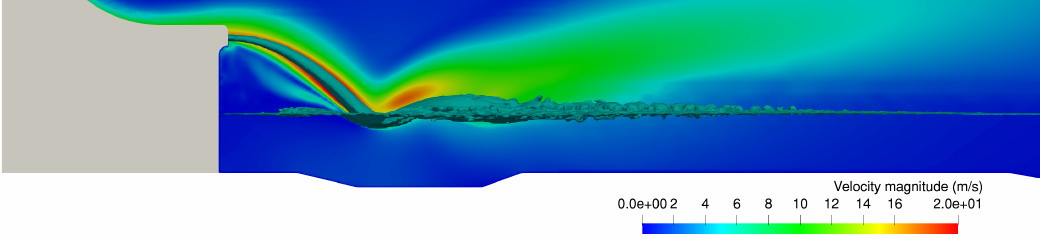
Figure 8. Visualisation of the overall water flow structure and velocity at discharge flow rate of 300 m 3 /s with the rear dam in place.